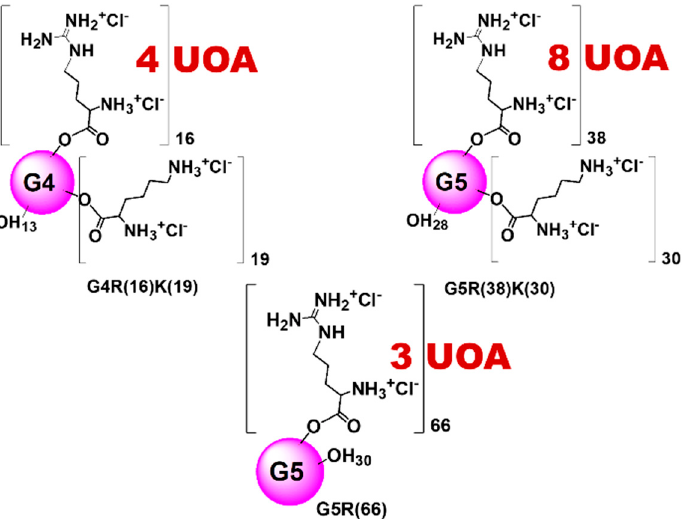
Figure 2. Schematic representations of the three CDs loaded with UA and OA (UOA) ((G4R(16)K(19)UOA(4), G5R(38)K(30)UOA(8) and G5R(66)UOA(3)) prepared in this study.